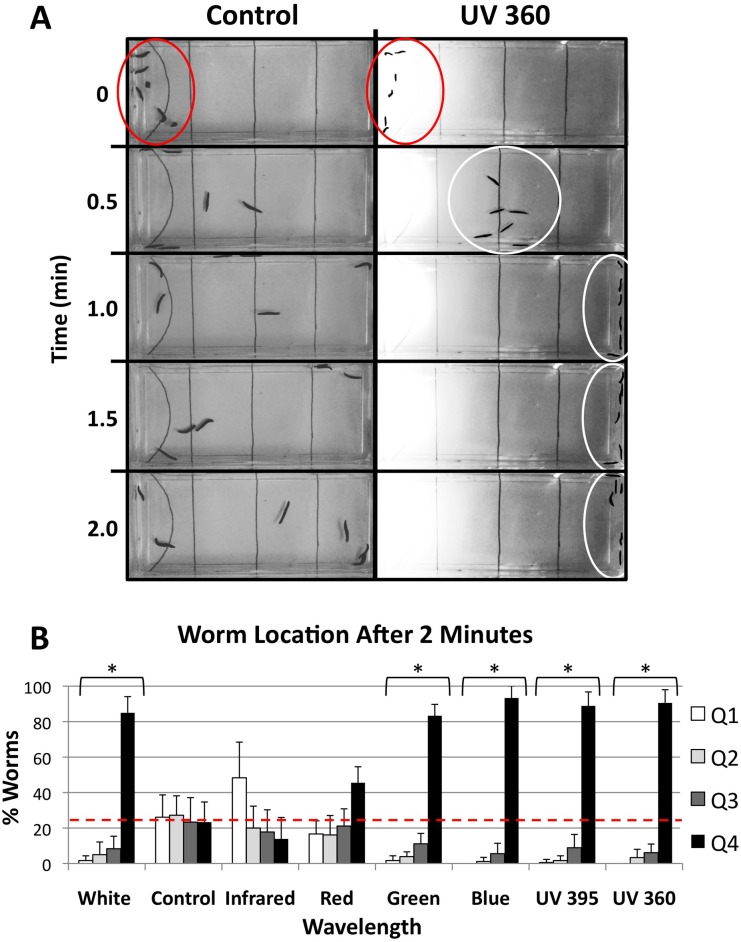
Planarian Photophobic Responses Vary by Wavelength.(A) Images of the photophobia assay showing single trials (one group, n = 6) for control (ambient light, left) and UV 360 (right) wavelengths. All worms begin in quadrant 1 (Q1, red circles). While control worms randomly explore the dish, in UV 360 trials worms move rapidly away from the light (white circles). Images enhanced for visualization. (B) Graph showing overall photophobic responses for each wavelength, as measured by worm location in each of the four quadrants (Q1–Q4) after 2 minutes. Photophobic responses are indicated by increased presence in Q4 (black bars) which is farthest from the light. Significance (asterisks = p<0.001 as compared to controls) was calculated by Mann-Whitney (with Dunn’s Q), which takes into account worm location across all four quadrants simultaneously. Red dashed line = average control value.